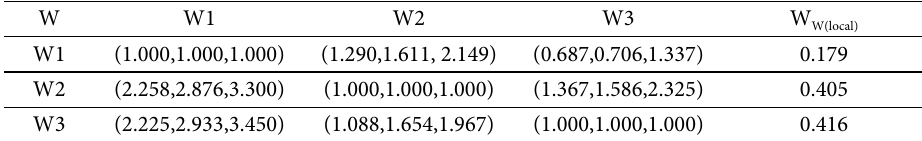
Table 9. Pair-wise comparison matrices and local weights for “W”-factor criteria